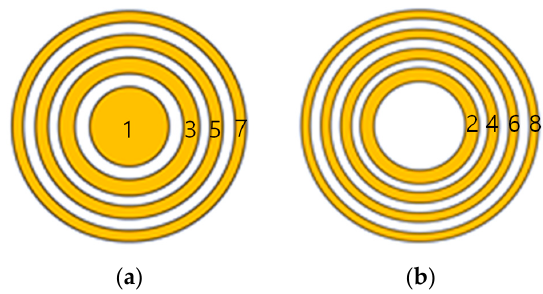
Figure 2. Two types of Fresnel zone plate: ( a ) Odd plate and ( b ) even